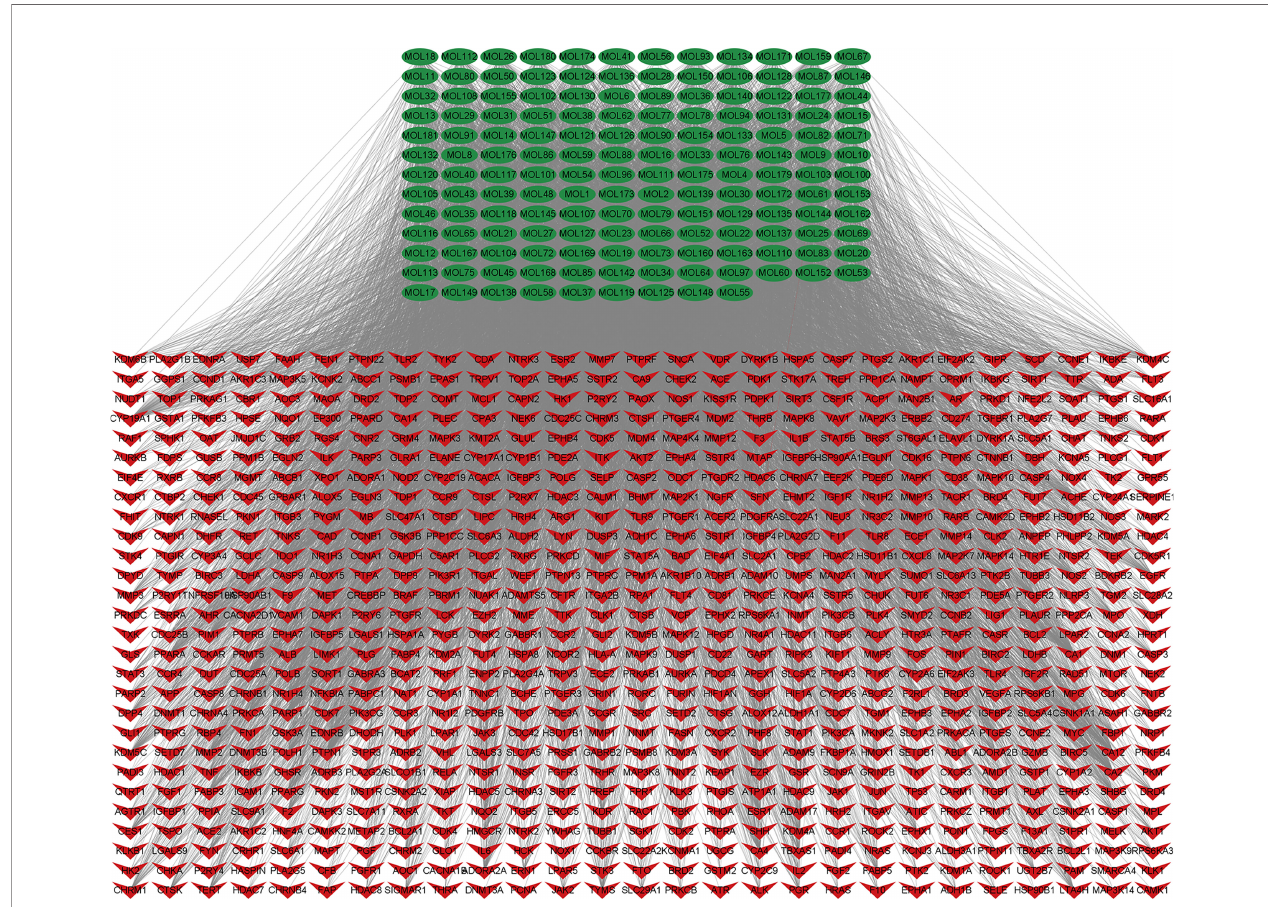
FIGURE 3 | The HMMCR active compounds – NSCLC targets network. The green circle represents compounds present in HMMCR, and the red circle represents targets.